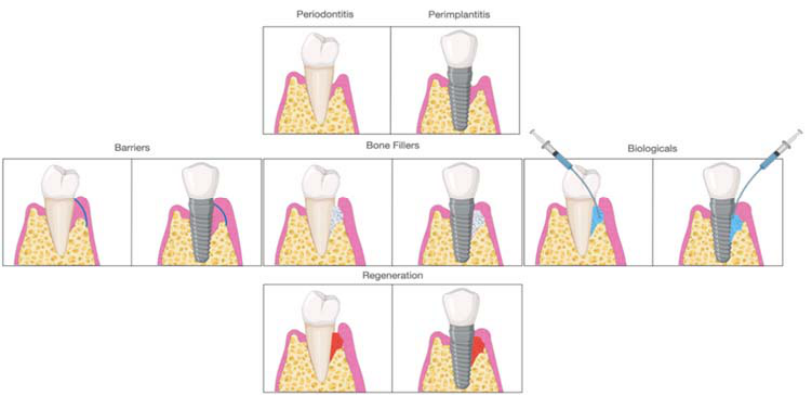
Figure 2. Approaches for regenerating periodontal and peri ‐ implant sites after treating the disease.